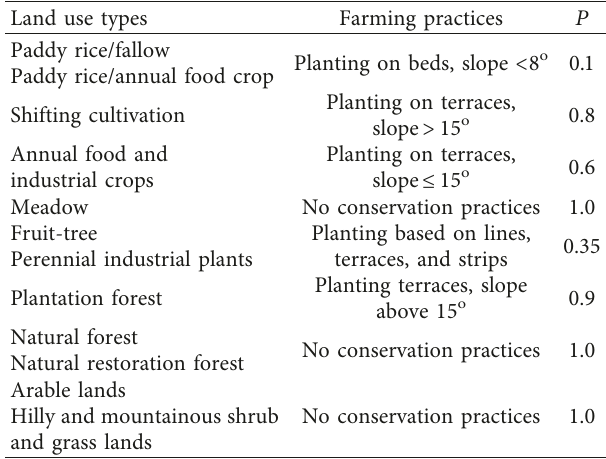
Table 3: The P value is based on land use types and farming practices.